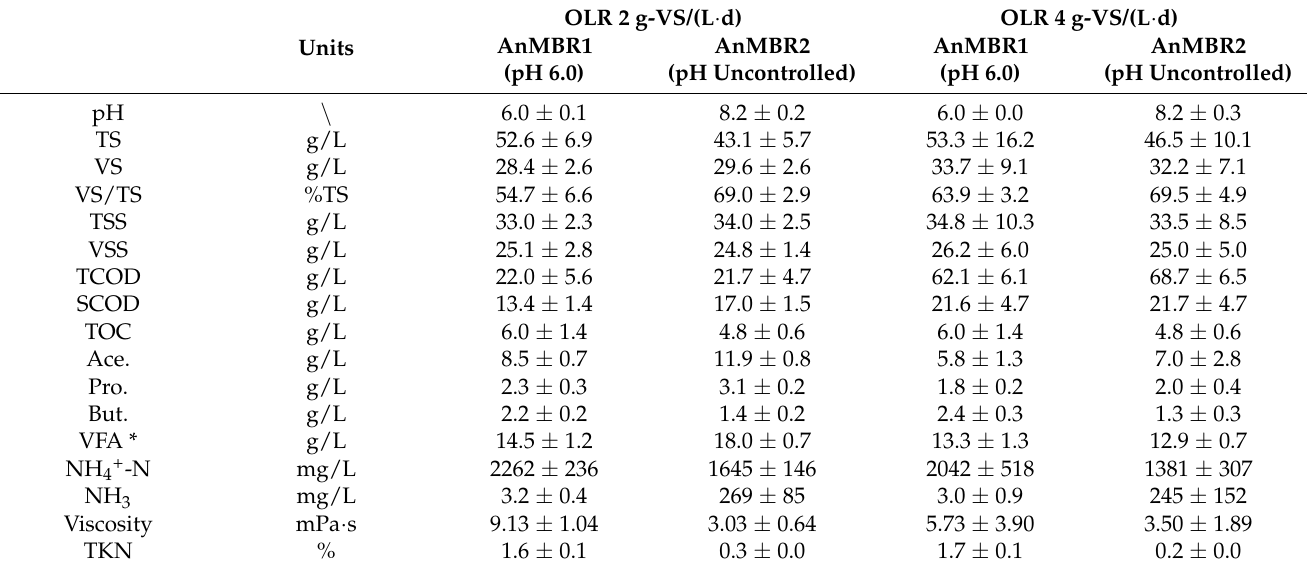
Table 3. Changes in the medium characteristics in AnMBR1 and AnMBR2 at OLRs 2 and 4 g-VS/(L ·